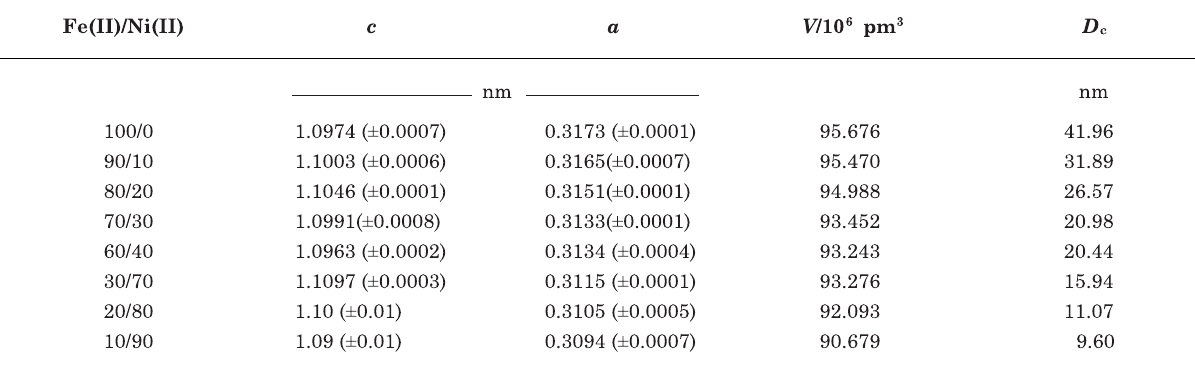
Table 2. Interplanar distances d ( c ), size of the unit cell along the a axis ( a ), volume of the unit cell ( V ) and 001 thickness ( D ) of crystallites along the c hexagonal axis as determined by the Scherrer formula in the c Ni(II)-GR2 samples, as a function of the divalent ion ratio in the starting solution,